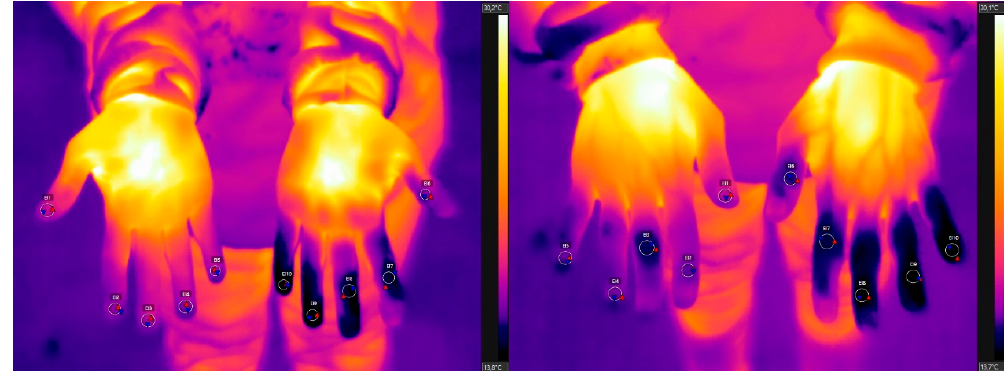
Figure 1. Thermographic images of the palm and dorsum, with the coldest areas of each finger identified.